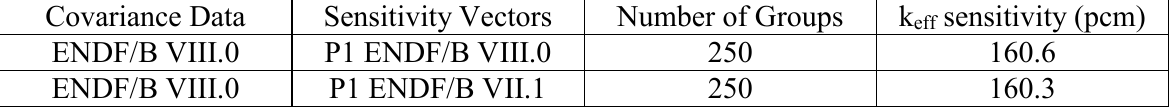
Table III. Jezebel Sensitivity to mubar